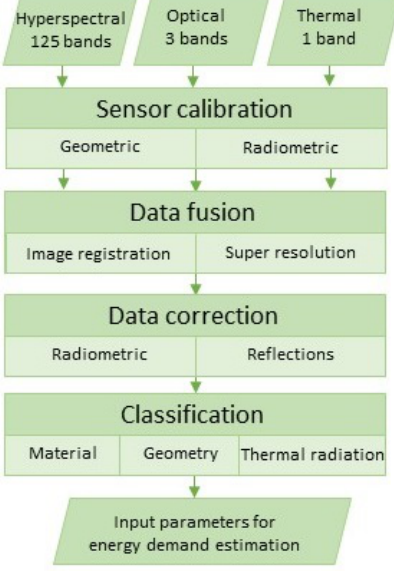
Figure 1. Proposed